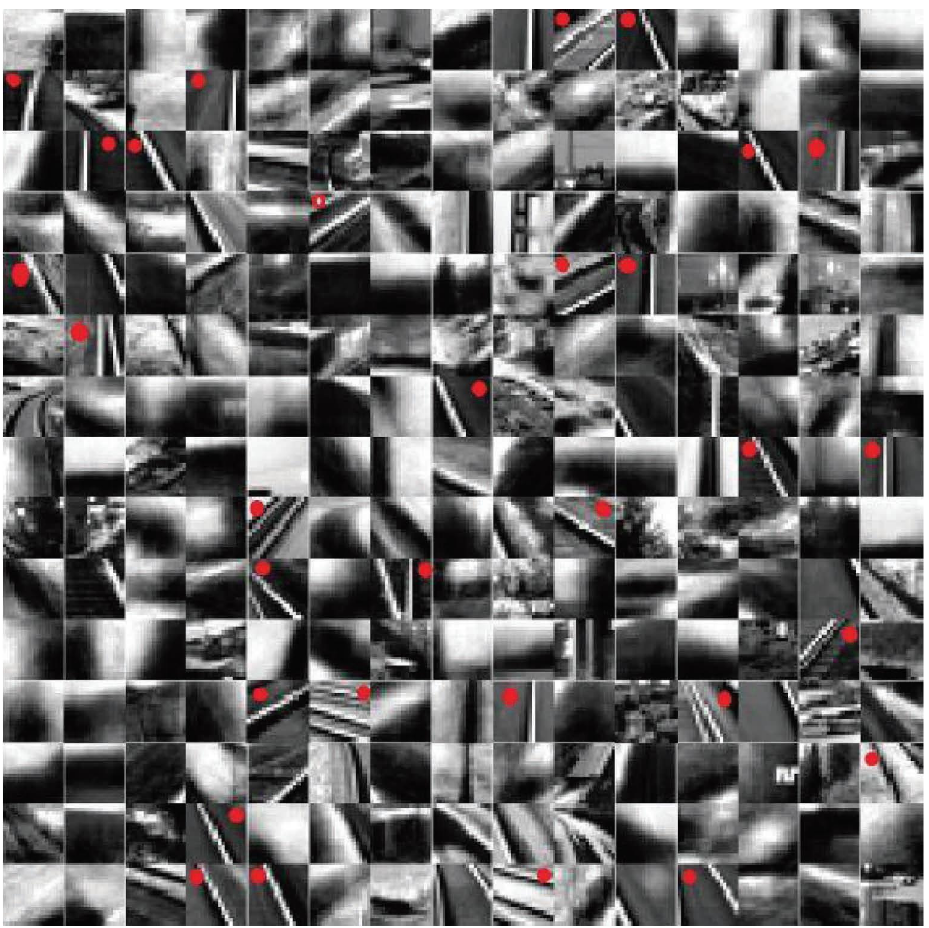
Figure 13: Examples of the visual words in the summer-fall dataset. Red circles indicate the visible words corresponding to the railway